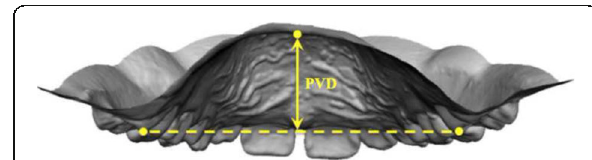
Fig. 5 Representation of the measurement of the depth of the palatal vault (PVD)